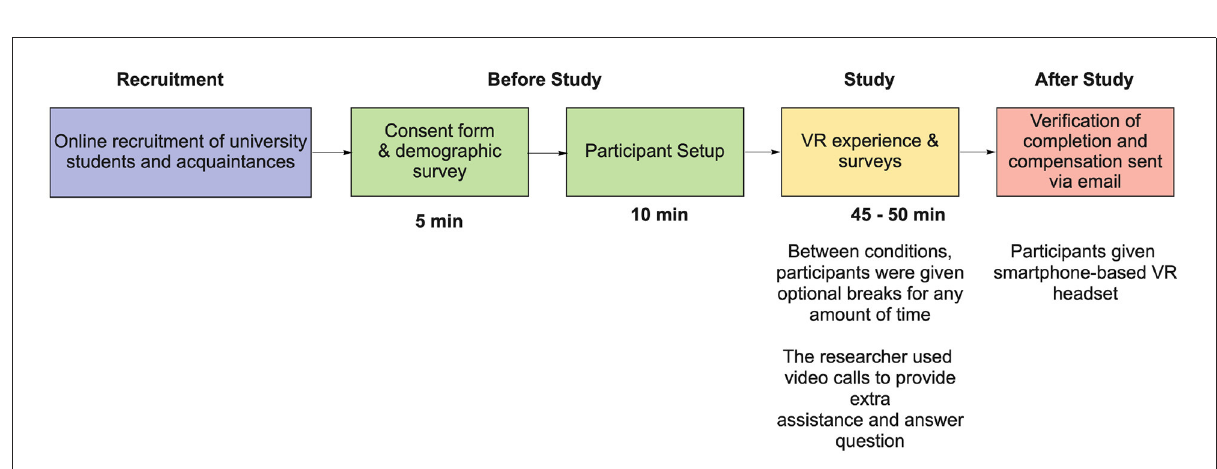
FIGURE10 Visualization of the study procedure of the redirected touch